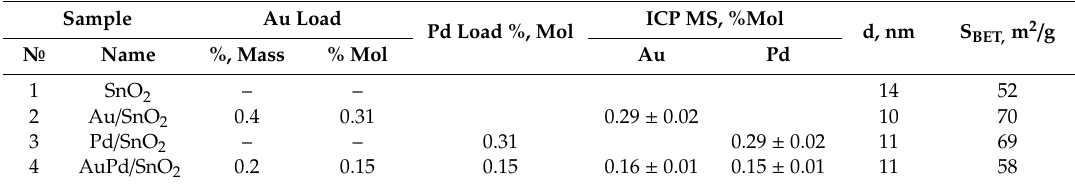
Table 1. Chemical content of noble metals in the composition of the synthesized materials (ICP-MS), average grain size (XRD, Scherrer Equation) and e ff ective surface area